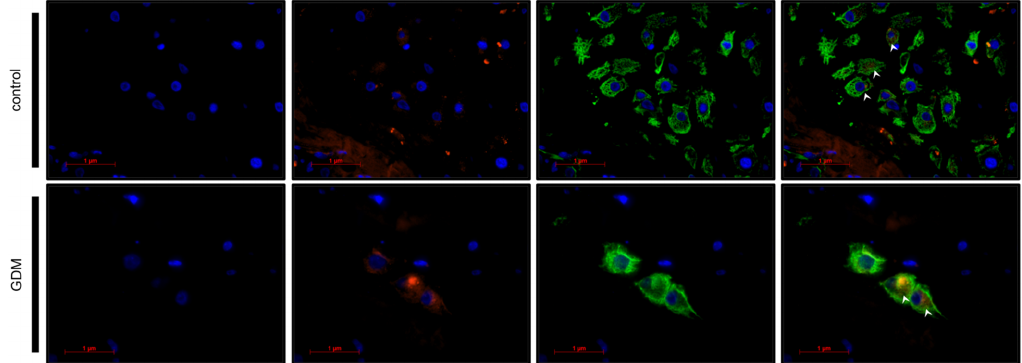
Figure 5. Double immunofluorescence phenotyping of decidual cell. Nuclei are stained blue using DAPI. Galectin-2, bound by Cy-3-labled secondary antibody, is stained red. CK7, bound by Cy-2-labeled secondary antibody is stained green, marking the extra-villous trophoblast (EVT) cells. Arrows heads indicate the merging expression of CK7 and galectin-2 visible as yellow. The scale bar equals 1 μm.